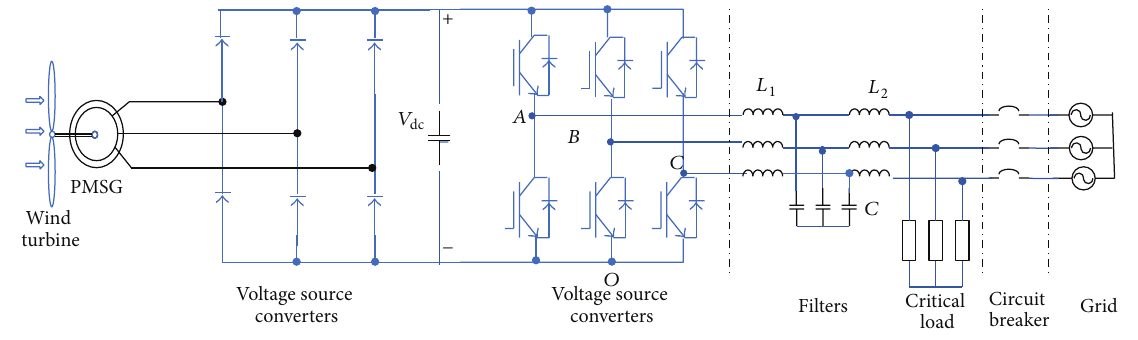
Figure 1: Schematic diagram of WECS interfacing to